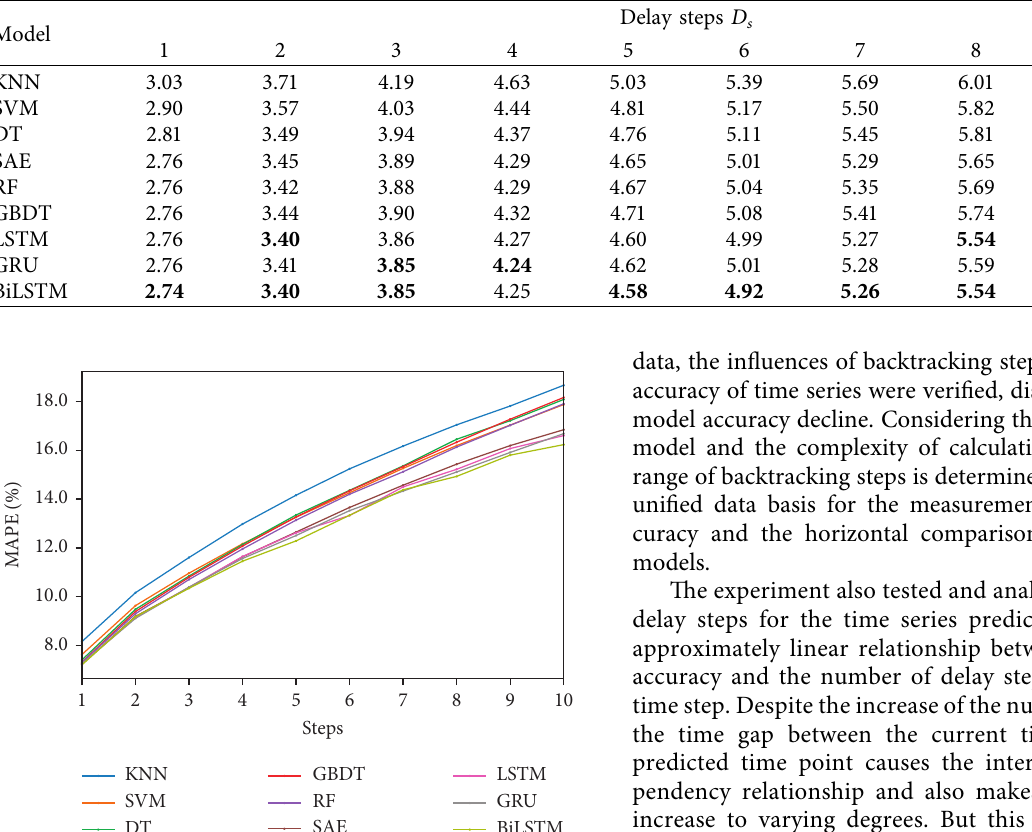
Figure 9: Multistep prediction results of different models on detector 16,395.